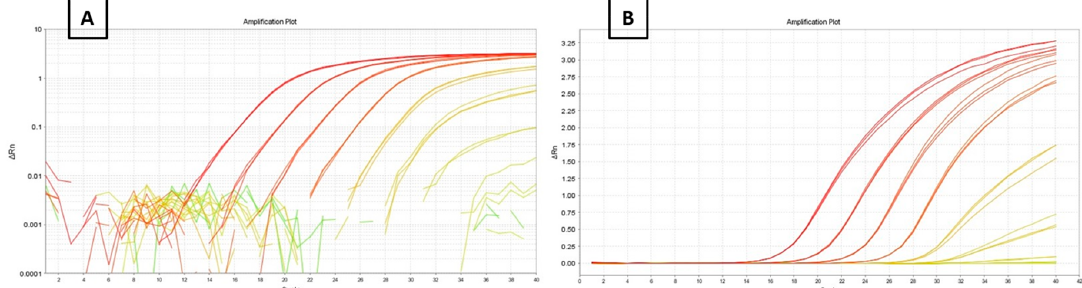
Figure 2. Amplification plots of the 10X dilution series of Sepia officinalis DNA ( A ): logarithmic, ( B ): linear.